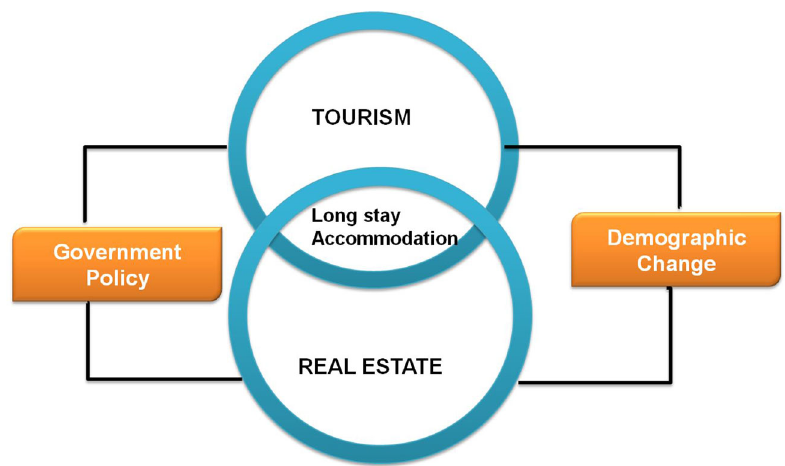
Figure 2. Conceptual